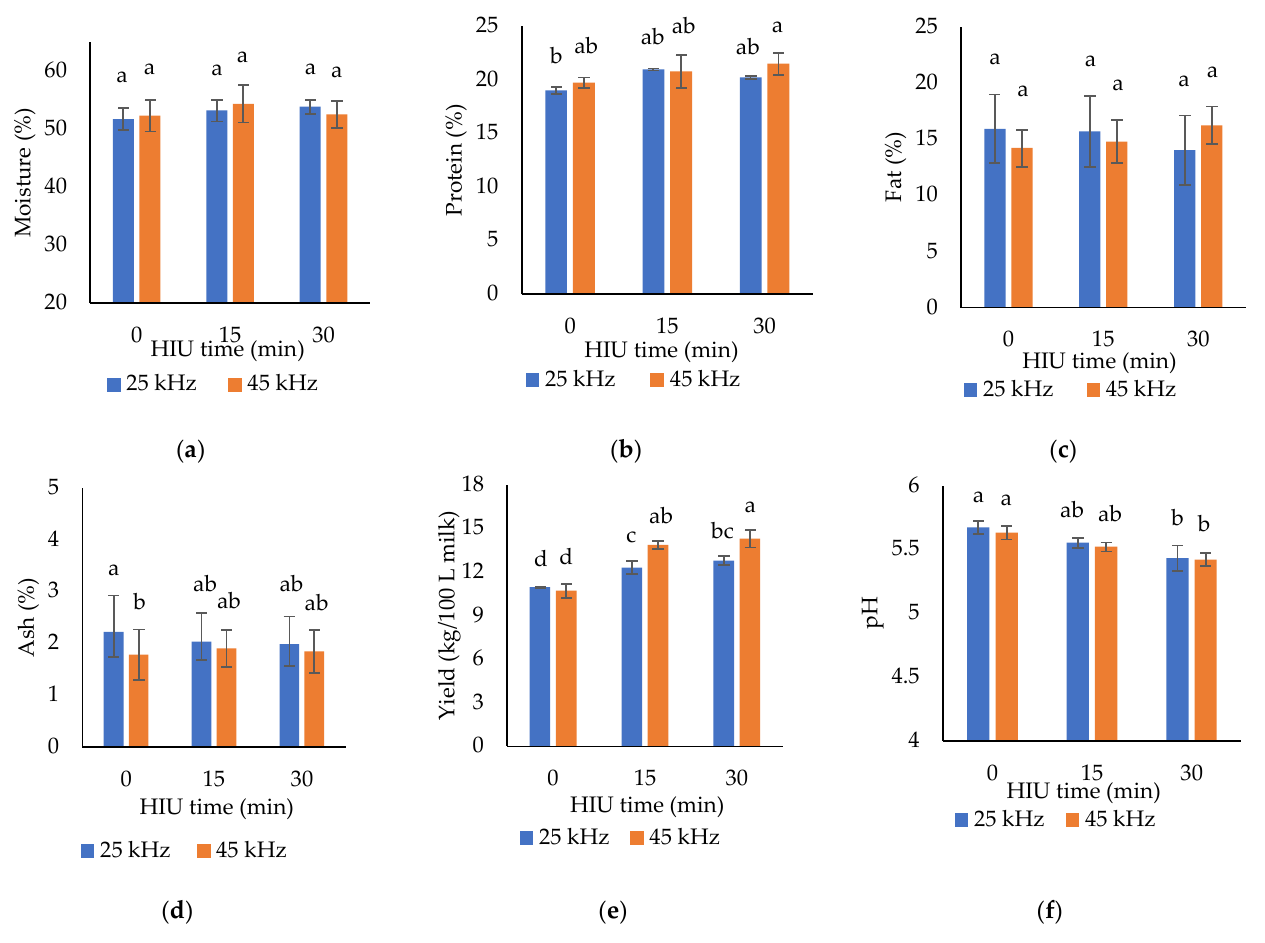
Figure 3. Effects of HIU frequency × HIU applied time to fresh raw milk on the pH ( a ), yield ( b ), and moisture ( c ), protein ( d ), fat ( e ) and ash ( f ) content of Oaxaca cheese. Data are expressed as mean ± standard deviation ( n = 3). a,b,c Different letters in the columns within the same graph indicate significant differences between treatments (Tukey´s multiple range tests assuming a significant difference at p < 0.05).